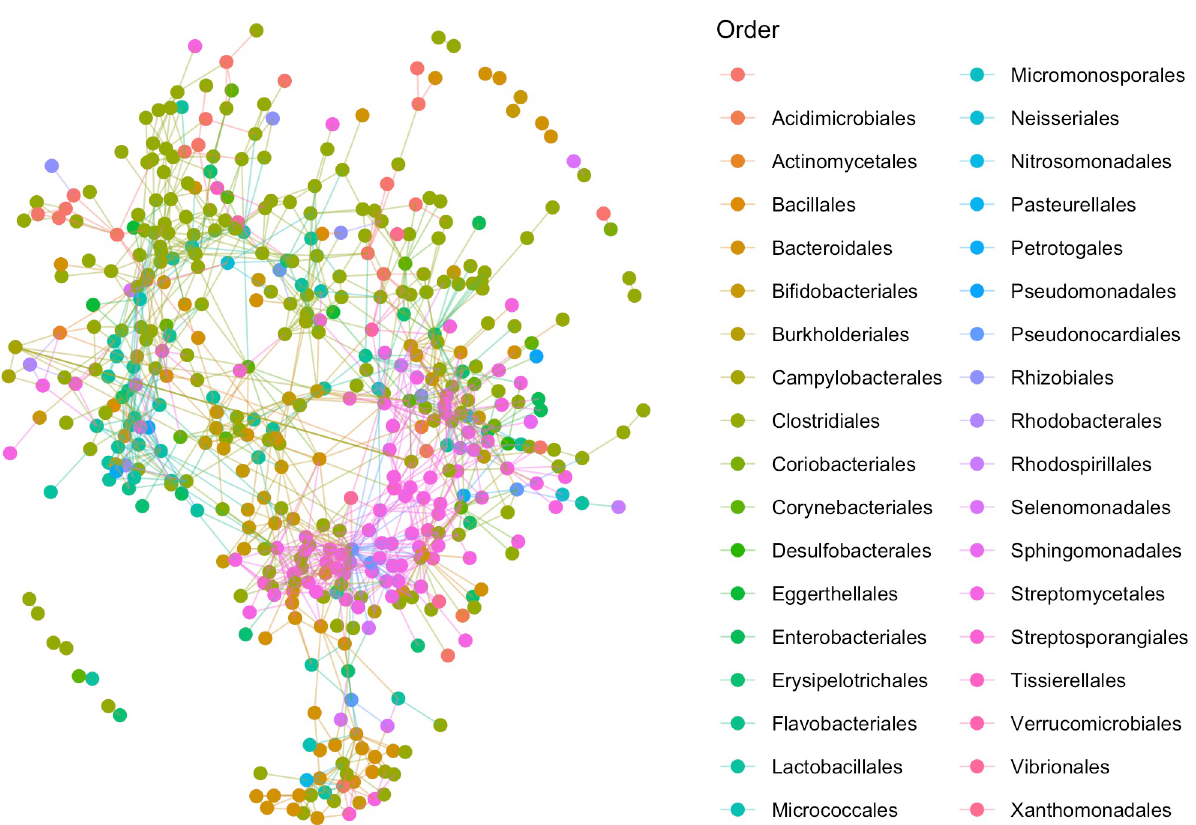
Fig 4. Species-level association network inferred from the LifeLines-Deep microbiomes. Nodes represent species and are colored according to their taxonomic order.